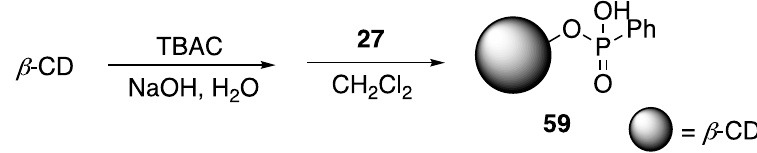
Figure 24. Reported preparation of 59 .